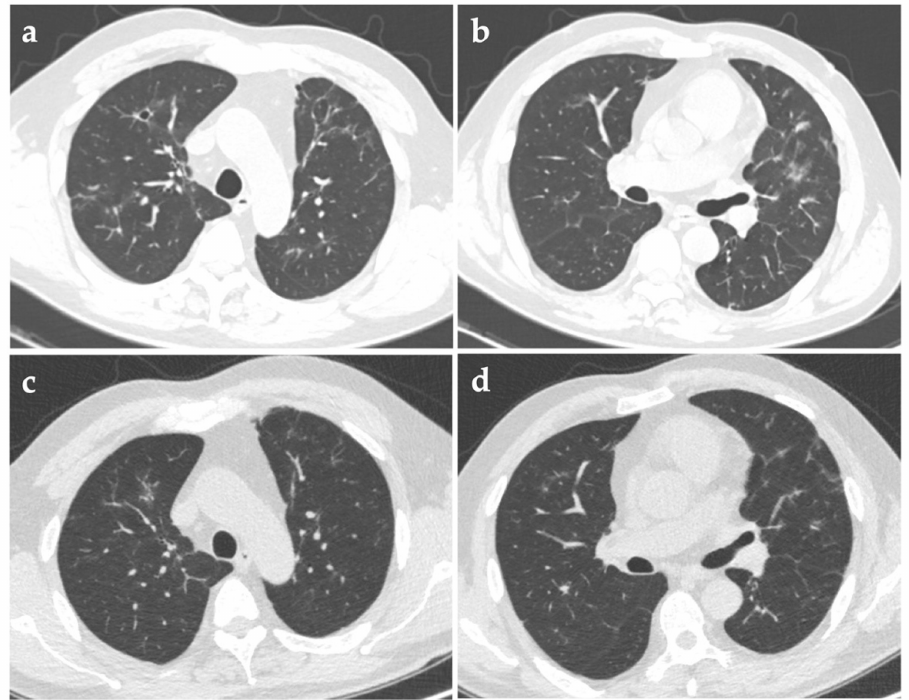
Figure 3. Repeated computed tomography (CT) images three months ( a , b ) and six months ( c , d ) after discharge, showing a significant reduction in both nodules and